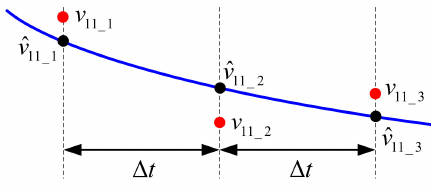
Figure 6. Actual sampling